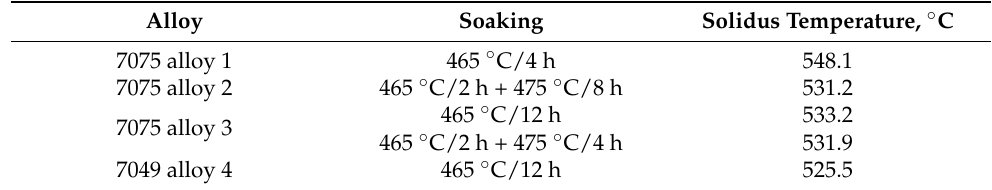
Table 5. Homogenization soaking parameters enabling maximizing the solidus temperature. Alloy